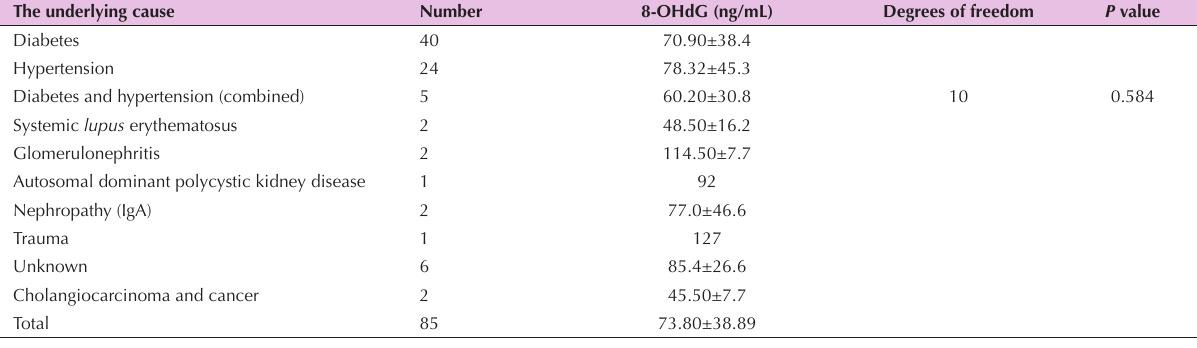
Table 8 . Comparison of mean serum 8-OHdG levels based on primary chronic kidney disease causes The underlying